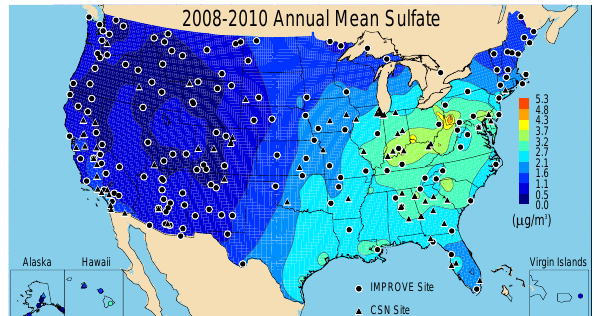
Fig. 2b. IMPROVE and CSN 2008–2010 annual mean particulate sulfate ion concentrations. Circles correspond to IMPROVE sites and triangles correspond to CSN sites.